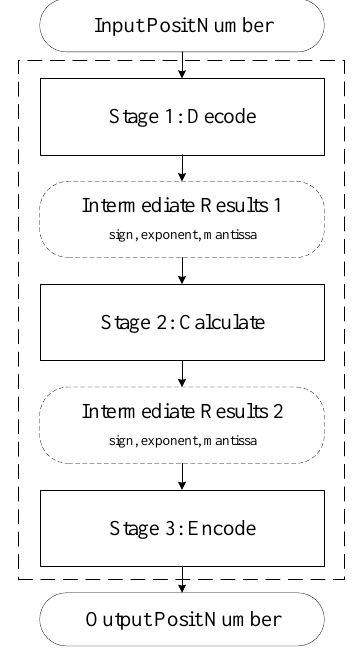
Figure 2. Three basic Posit arithmetic